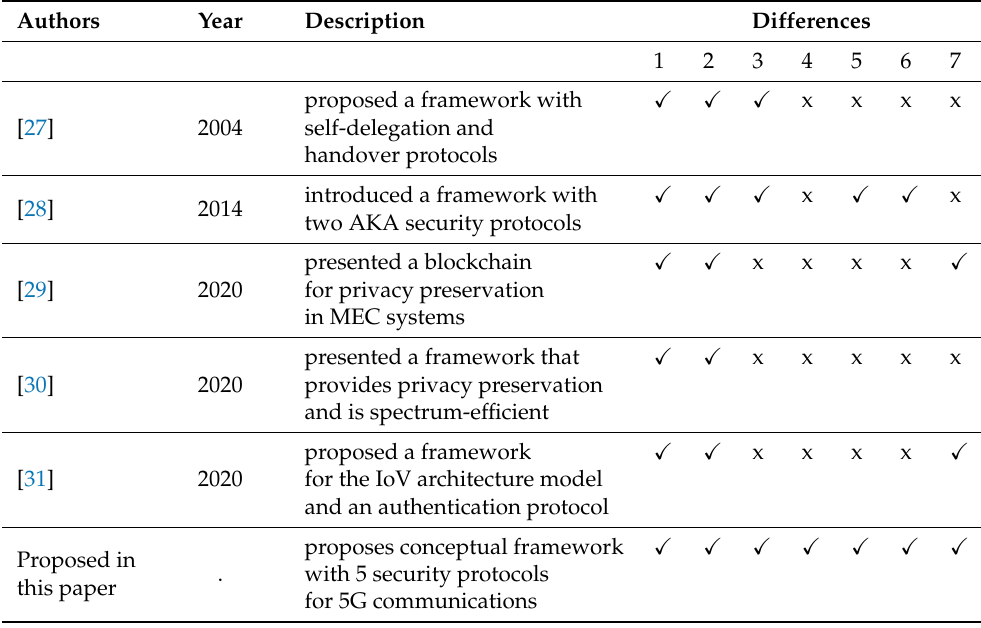
Table 1. Comparison of Related Work Based on the Proposed Conceptual Framework.